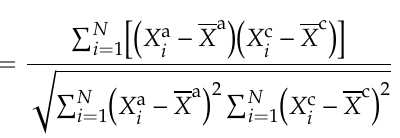
/ D 50 ) 0.13 log10 ( V / V m